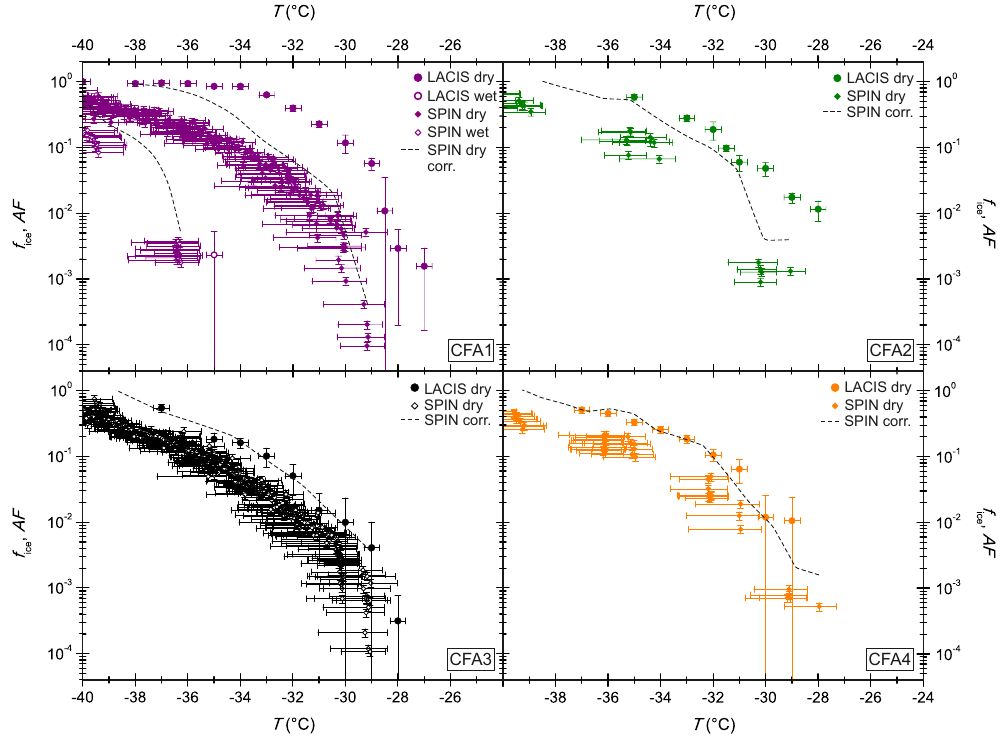
Figure C1. Comparison of CFA immersion freezing measurements with SPIN and LACIS (300nm particles). Dashed lines indicate interpo- lated SPIN data after a correction factor of 3 is